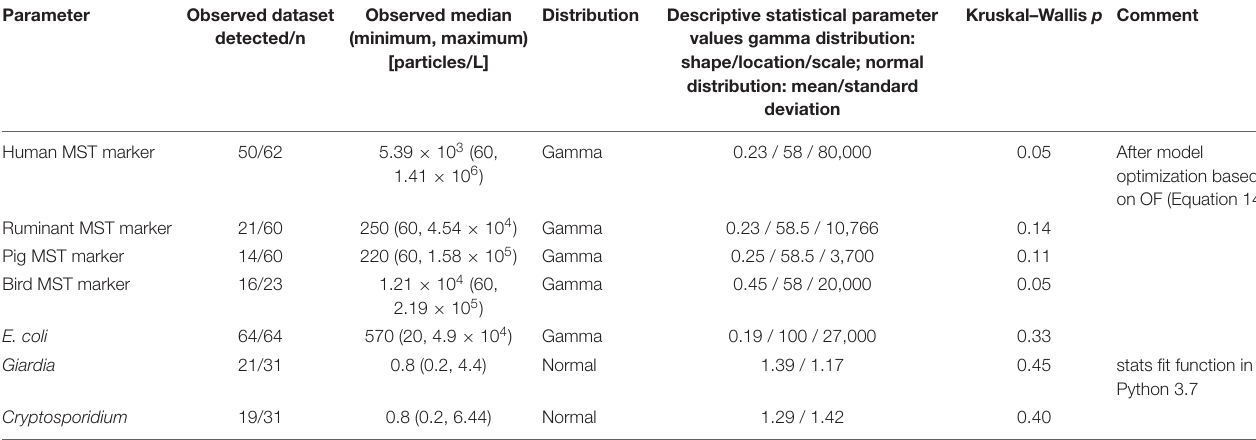
TABLE 3 | Observed values and descriptive statistics for the microbial concentrations of the Danube from 2010 to 2015 (C r in Equation 1) and the Kruskal–Wallis test results showing that the simulated and observed values were not significantly different ( p ≥ 0.05).